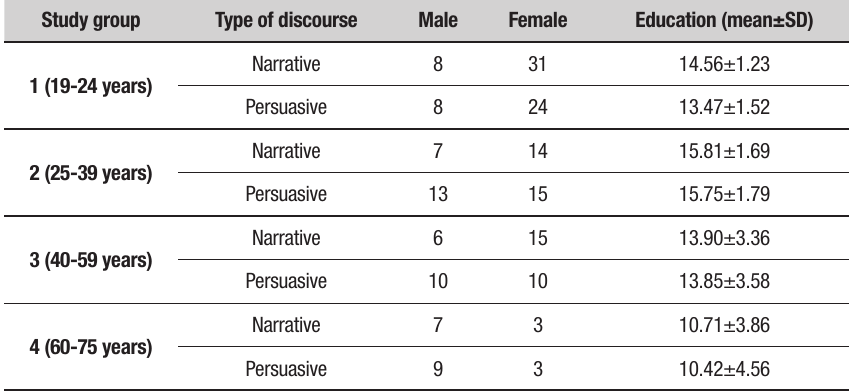
Table 1. Demographic characteristics of subjects in different age